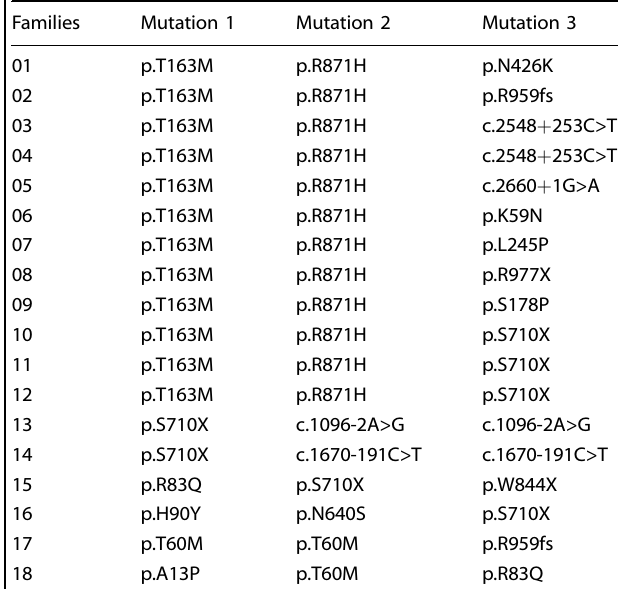
Fig. 1 Topology of human NCC with position of each mutation in this study. Amino acid exchanges of the mutations identi fi ed in this study are shown and their locations are indicated by arrows. Table 1. Triple pathogenic SLC12A3 mutations in 18 unrelated GS